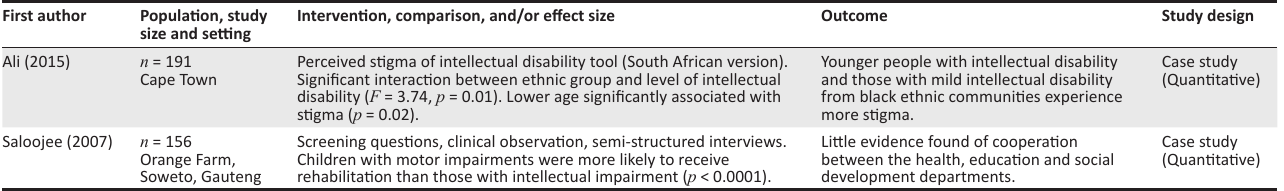
TABLE 3a: Examples of data extraction forms – Population, Intervention, Comparison, Outcome, Study design: For quantitative studies.